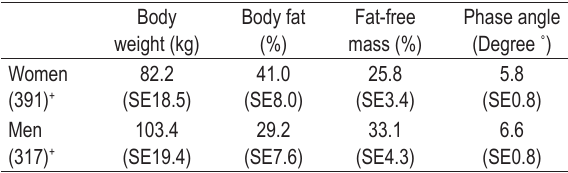
TABLE 1. A descriptive statistic of the sample was a total of